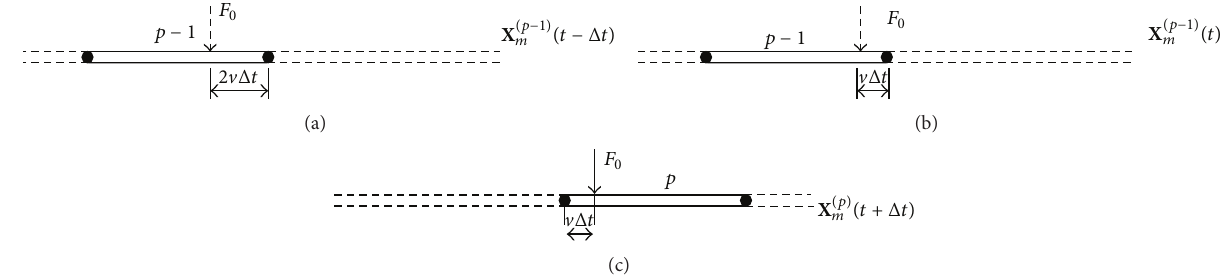
Figure 5: Loading situation of three adjacent time steps: (a) 𝑡 − Δ𝑡 , (b) 𝑡 , and (c) 𝑡 + Δ𝑡 .